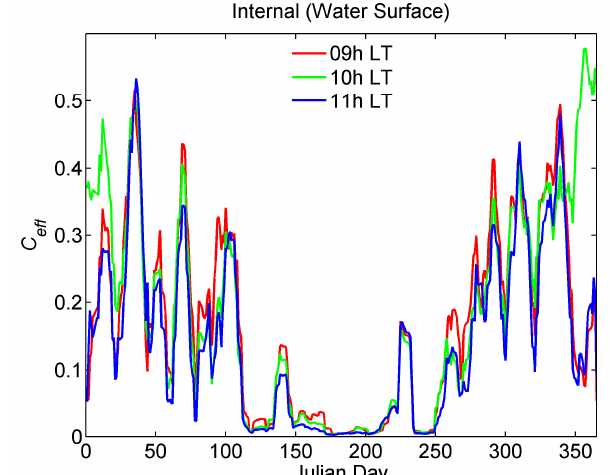
Figure A2. Annual cycle of hourly e ff ective cloudiness index ( C ef f ) for 9 h, 10 h and 11 h LT for the Serra da Mesa reservoir internal area.